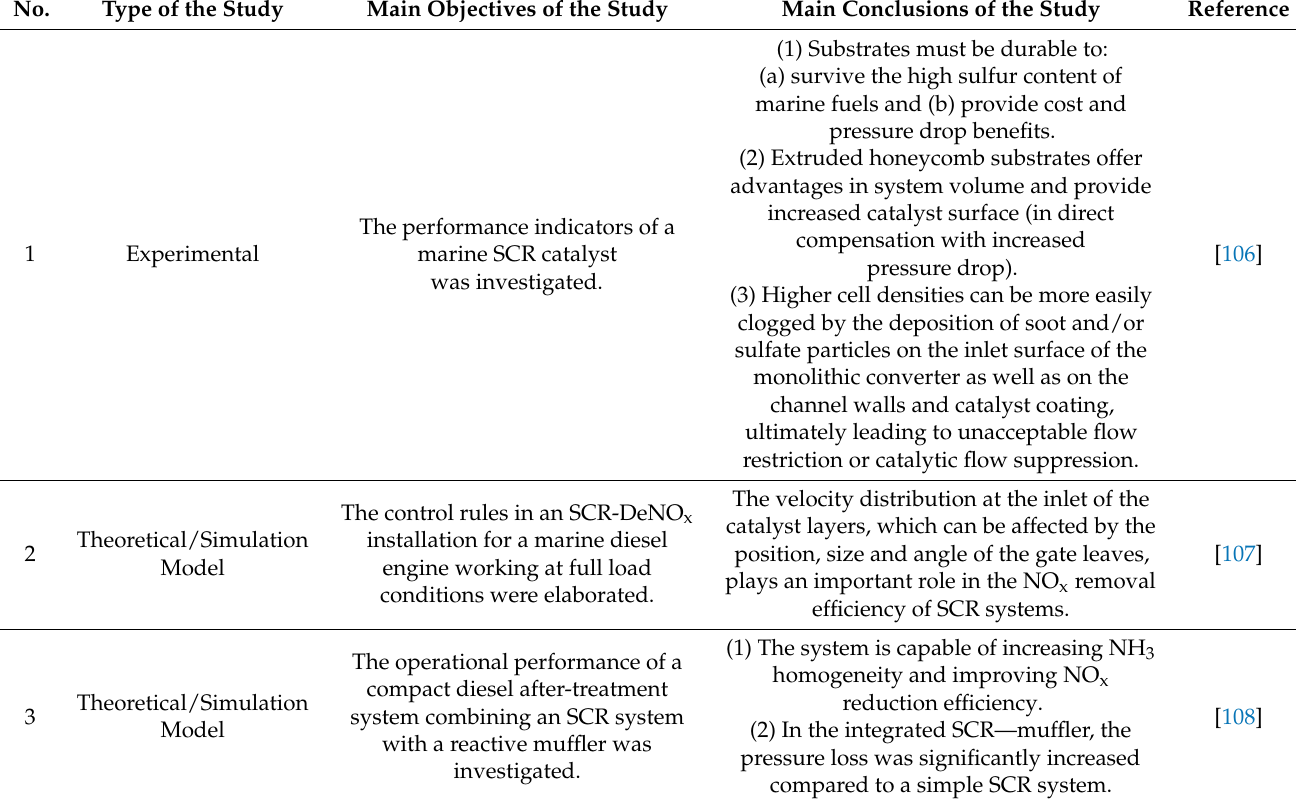
Table 6. Consolidation of the review results for marine SCR systems. For each published study listed in this table is shown by type (theoretical, experimental or review study), its main objectives and its main conclusions along with its